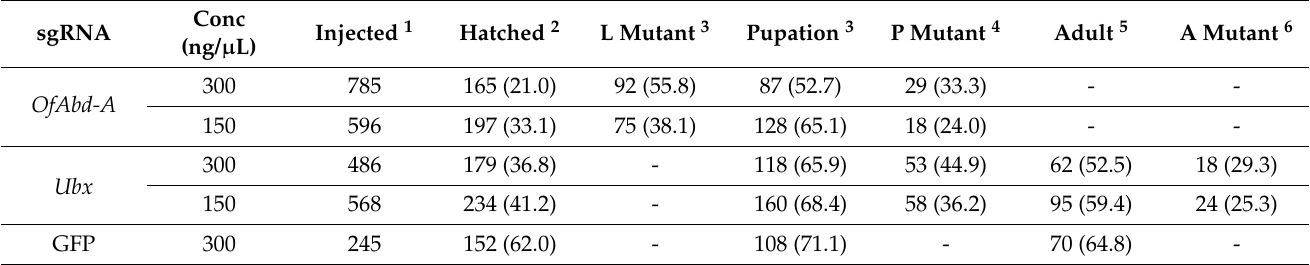
Table 1. Mutation frequency of CRISPR/Cas9-mediated mutagenesis in O. furnacalis .